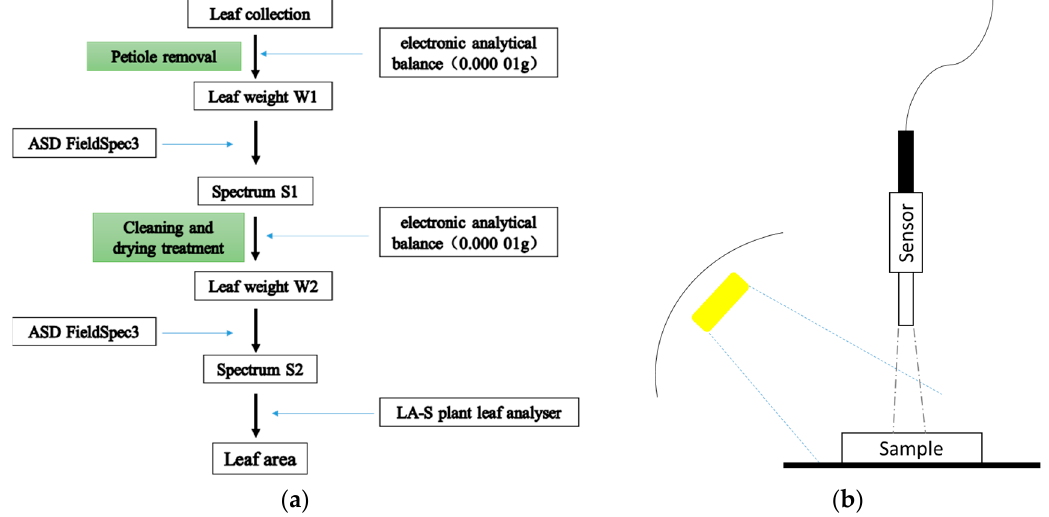
Figure 3. ( a ) Main processes of indoor measurement, and ( b ) schematic diagram of spectral reflectance measurement.